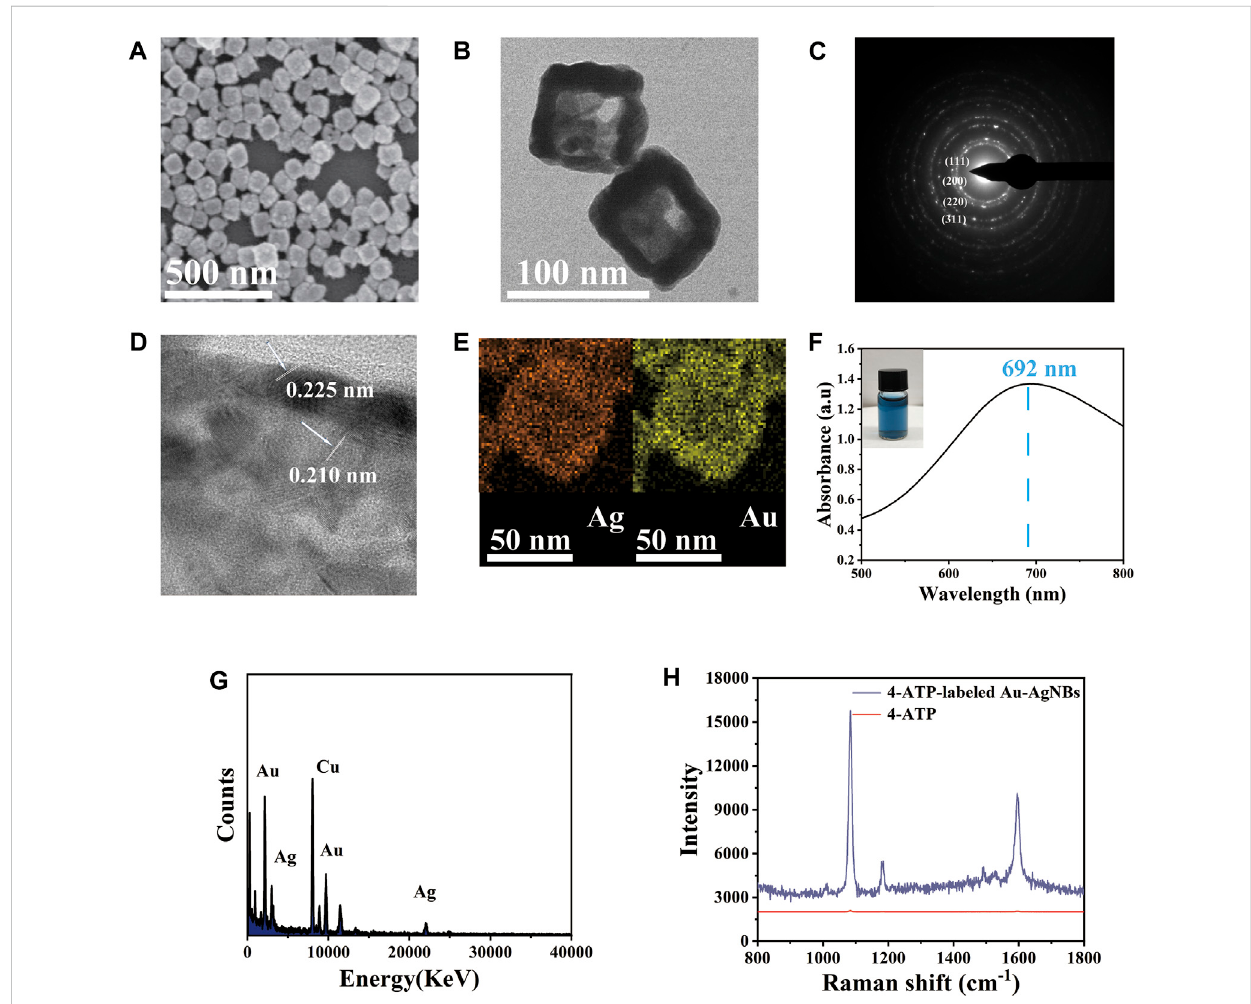
FIGURE 1 The representative structure of Au-AgNBswas generated inone step. (A) SEM of Au-AgNBs, (B) TEM, (C) SAED image, (D) HRTEM and EDX mapping (E) forAgelementandAuelementimage, (F) UV-Vis-NIRabsorptionspectrumofAu-AgNBs. (G) EDXspectraofAu-AgNBs. (H) SERSspectraof4-ATPand 4-ATP-labeled